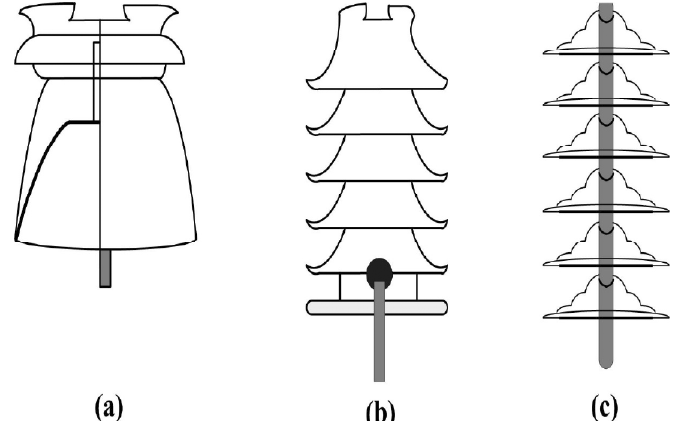
Fig. 13. A: Pin-type-insulator, B: Post-type-insulator, C: Suspension-type-insulator (Redrawn and adapted figure from [190]).